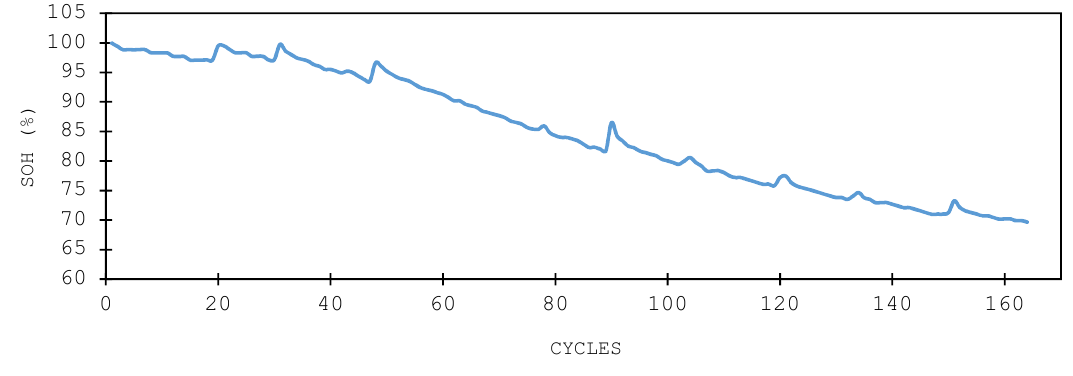
Figure 3. The state of health of battery No. 05.